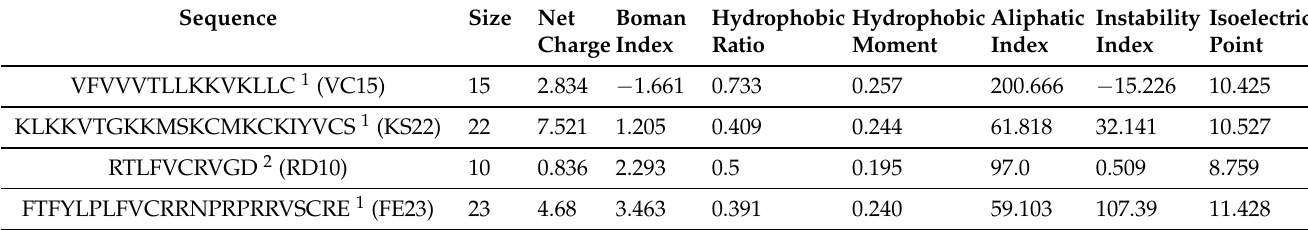
Table 7. Physicochemical properties of selected peptides. Values for each selection criteria on the four peptides selected for in vitro experimentation. 1 Monofunctional peptides: AMPs. 2 Bifunctional peptide: AMP + CPP.